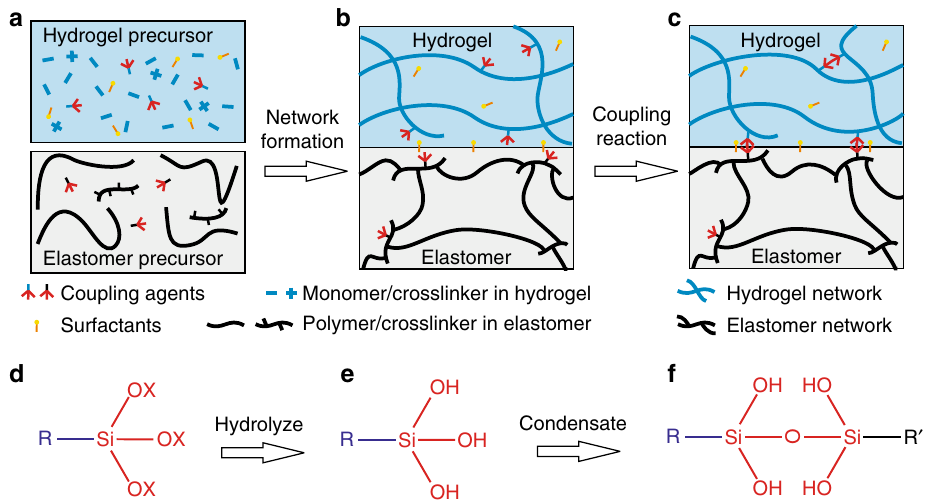
Fig. 1 A hydrogel and an elastomer form covalent bonds after a manufacturing process. a Silane coupling agents are mixed into the precursors of a hydrogel and an elastomer separately. b During the formation of the two networks, the coupling agents are covalently incorporated into the networks, but do not condensate. c After a manufacturing process, the coupling agents condensate, add crosslinks in the individual networks, and form bonds between the networks. A surfactant may further promote adhesion. d Silane coupling agents hydrolyze and form e Silanol groups, which condensate to form f